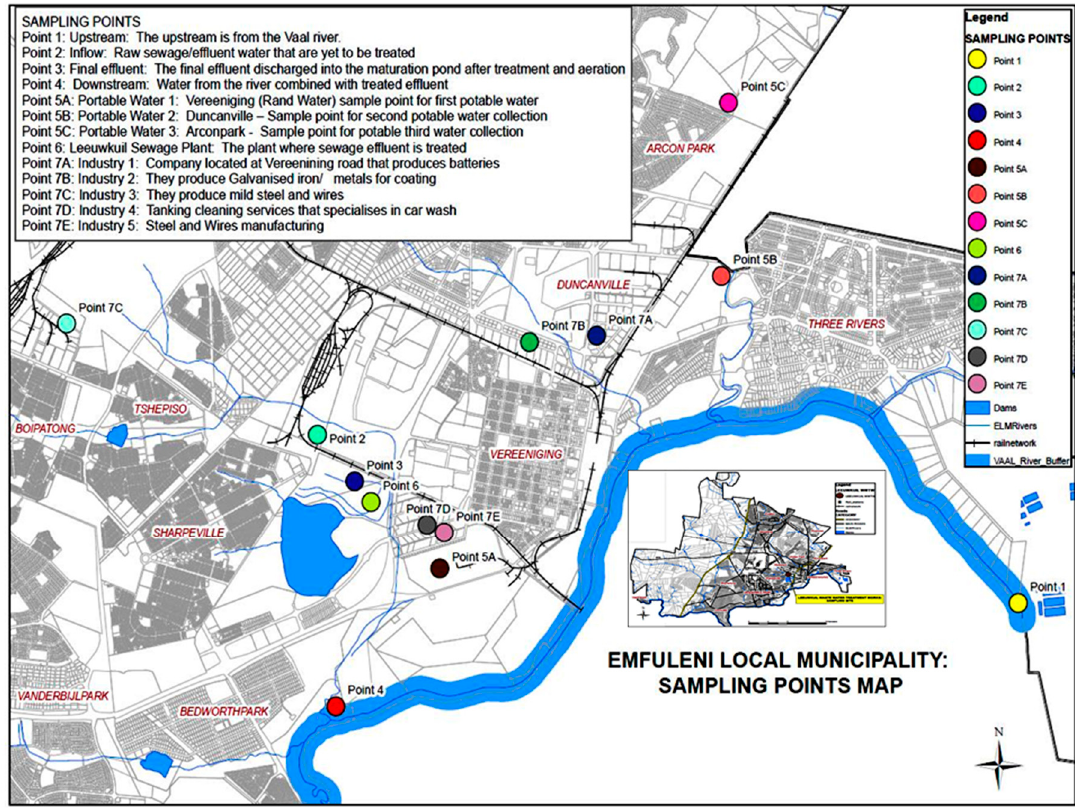
Figure 1. Map showing the study area and sampling points within Emfuleni Local Municipality, Gauteng Province, South Africa.